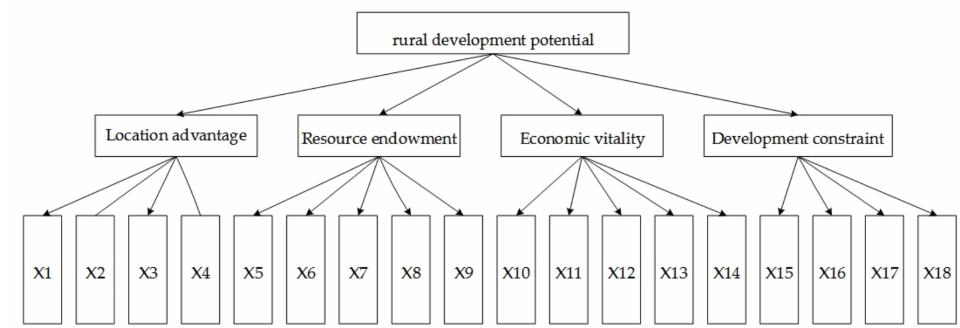
Figure 2. Hierarchical structural mode. 4 (cid:13) Evaluation model of rural development